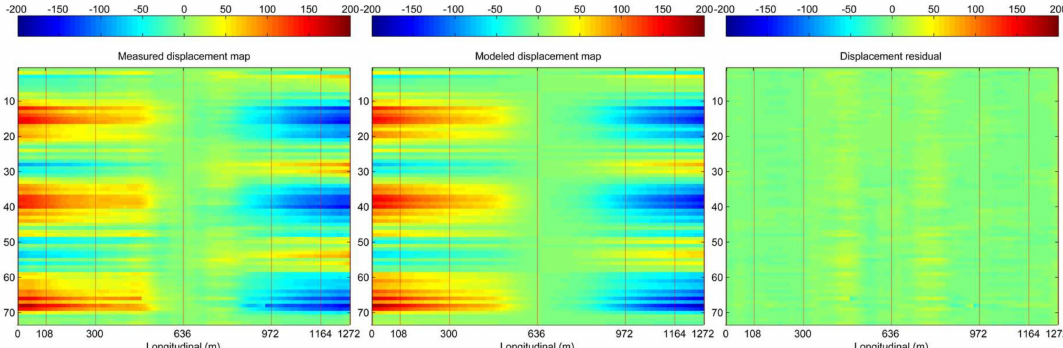
Figure 13. Accuracy evaluation of the bridge displacement model over Track 01. Measured displacement time series ( left ), modeled displacement time series ( middle ), and their difference ( right